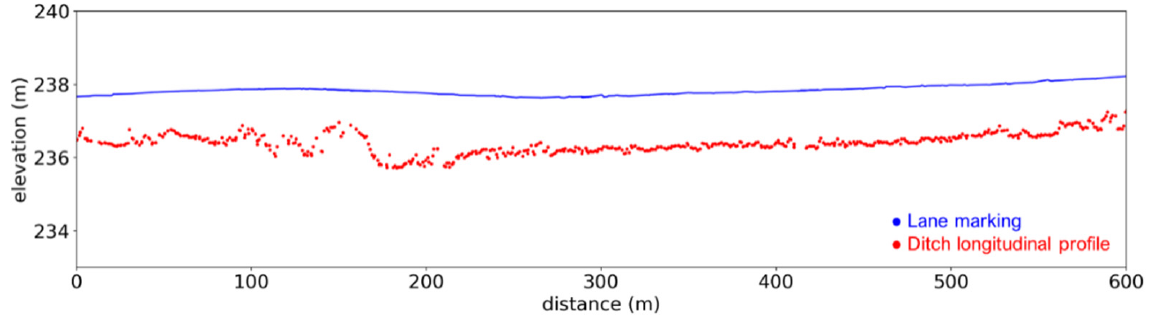
Figure 9. An example of a longitudinal profile together with the detected lane marking.